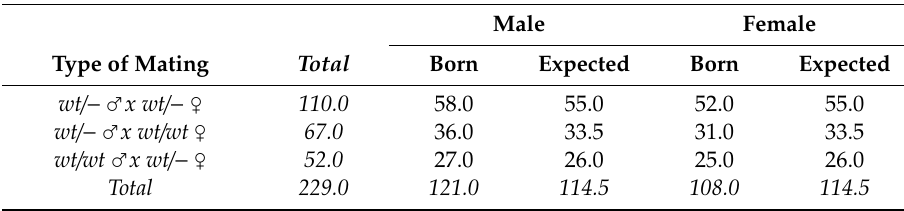
Table 1. Distribution of o ff spring in di ff erent type of mating according to sex. − indicates targeted Lonp1